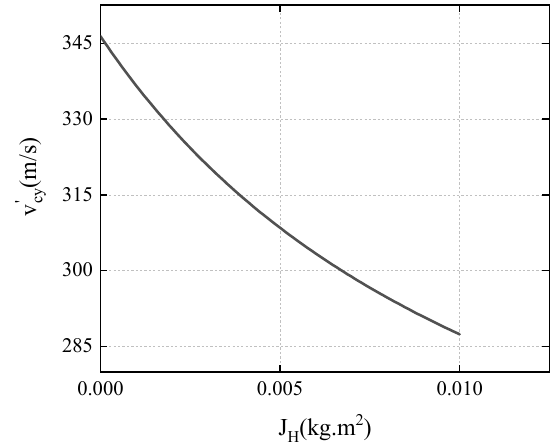
(cid:48) cy with J H